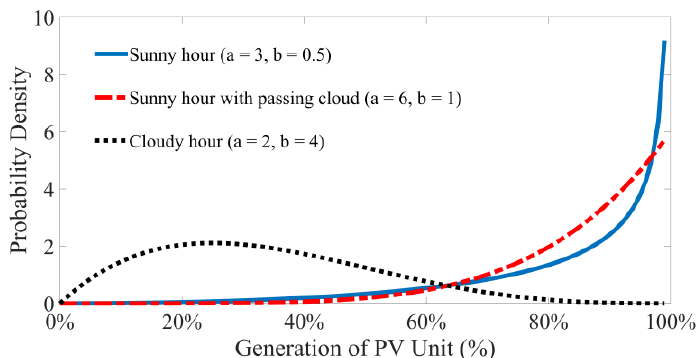
Figure 2. Probability distribution functions of PV generation and weather effect.